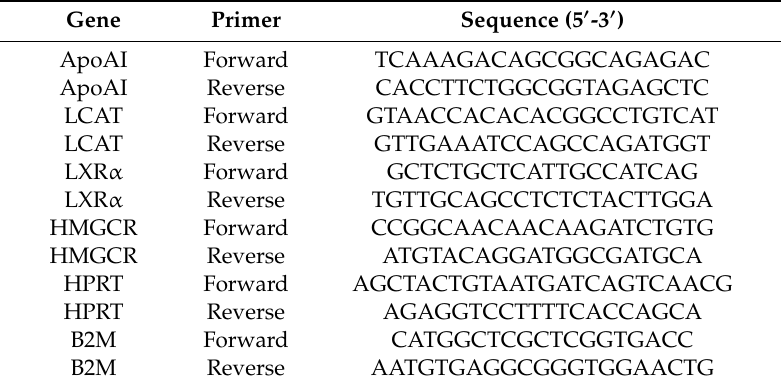
Table 2. List of primers used for real-time PCR